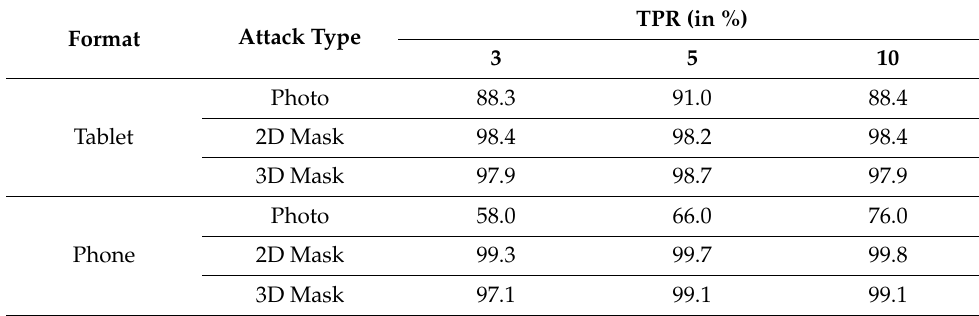
Table 2. TPR at FPR = 0.10 for various challenge durations (in sec.) (trajectory: Lines